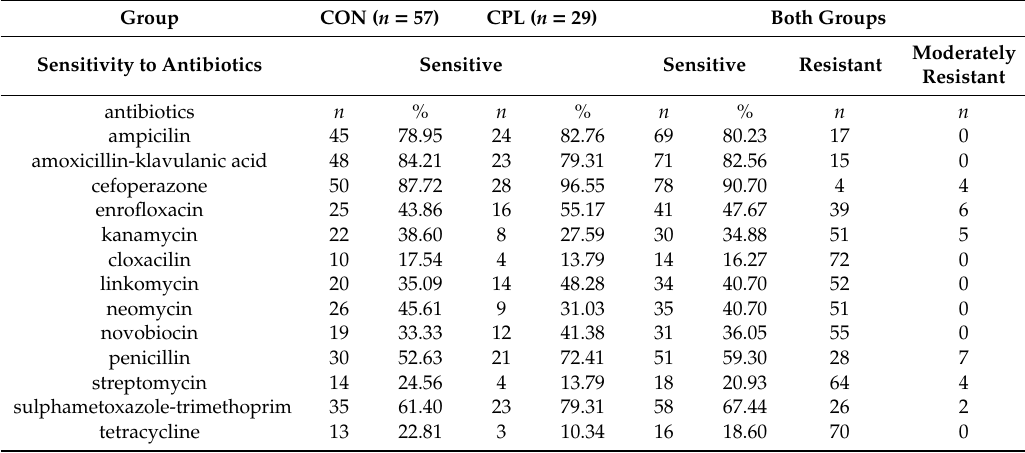
Figure 1. Number and percentage of causative pathogens isolated in the clinoptilolite (CPL) supplemented group (udder quarters n = 29) and in not treated group (control (CON)) (udder quarters = 57). Table 1. Sensitive, resistant, or moderately resistant bacteria (isolated from udder quarters) to antibiotic action (from a total of 86 positive samples) in the control (CON) and clinoptilolite (CPL) supplemented group of dairy